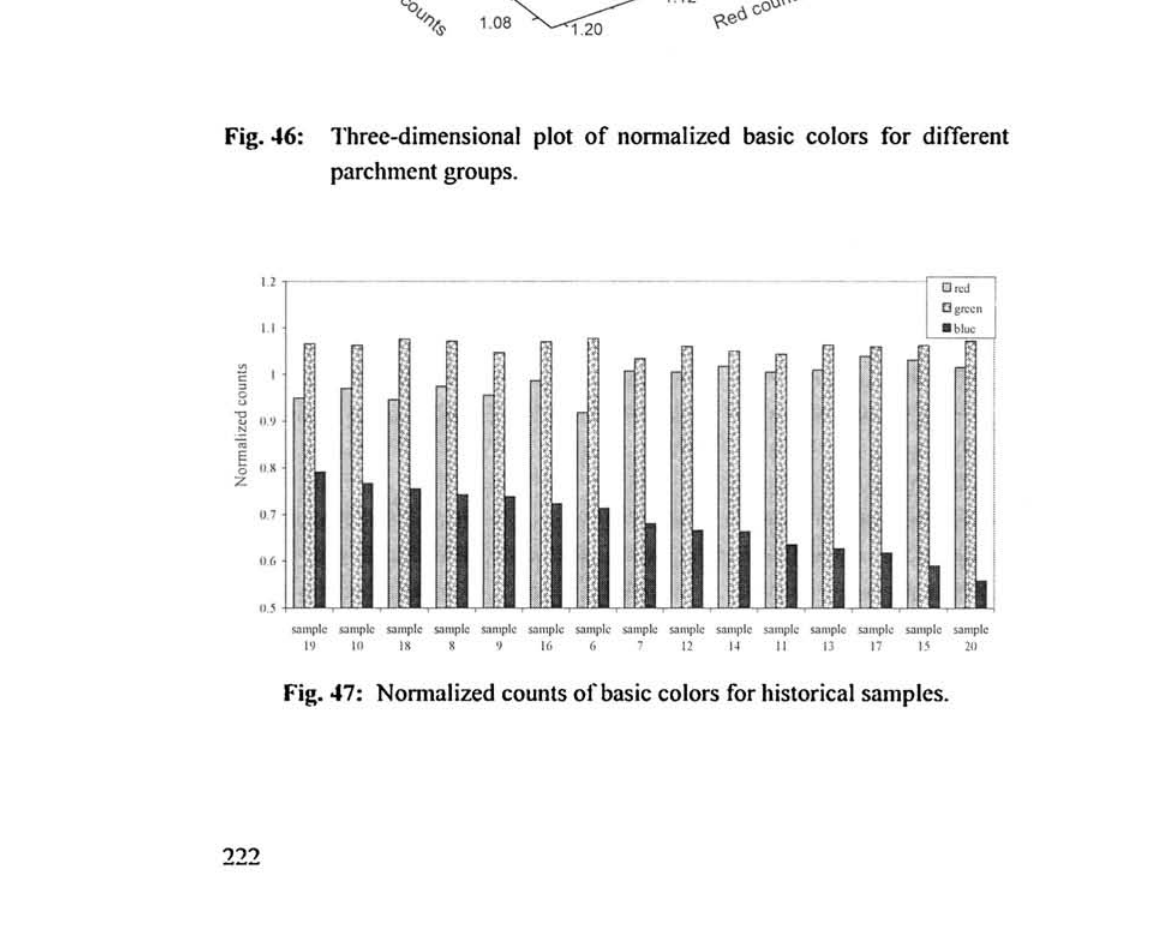
Fig. 46: Three-dimensional plot of normalized basic colors for different parchment groups.